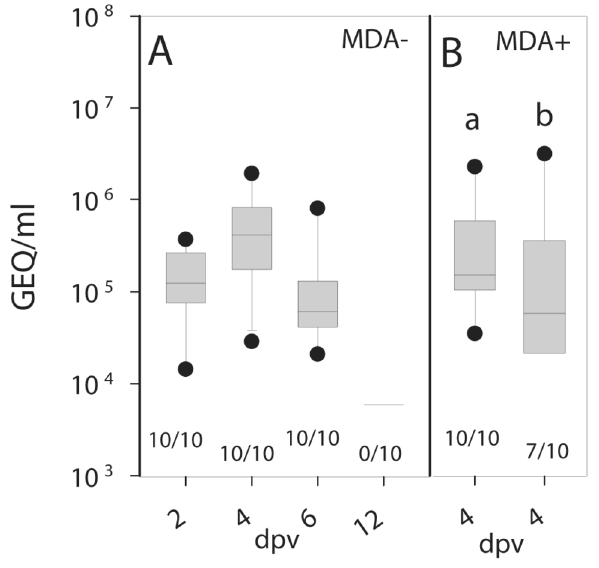
Figure 6. Virus shedding after vaccination. Swab samples taken on the indicated days from oropharynx of MDA- chickens (A) immunized with chNDVFHN H5 at three weeks of age PMV8 and swabs combined from oropharynx and cloaca of MDA+ chickens (B) immunized on day 1 (group a) or day 7 (group b) after hatch were analyzed for the presence of NDV NP gene- specific RNA by RT-qPCR. Values were transformed to genome equivalents (GEQ) using calibration curves of defined RNA standards that were included with each RT-qPCR run. The number of positive swabs by RT-qPCR is given below the box plots. Significant differences (P < 0.0125, Bonferroni correction) between vaccinated groups and controls are indicated (*).